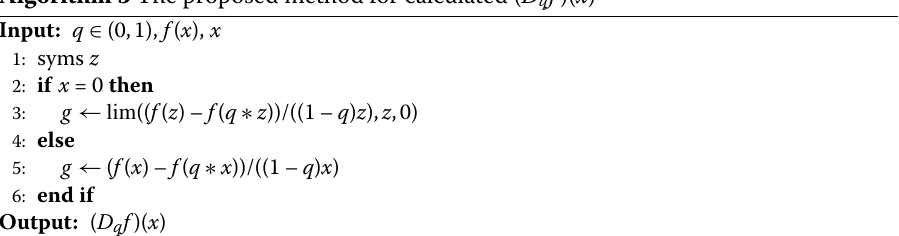
Algorithm 3 The proposed method for calculated ( D q f )( x